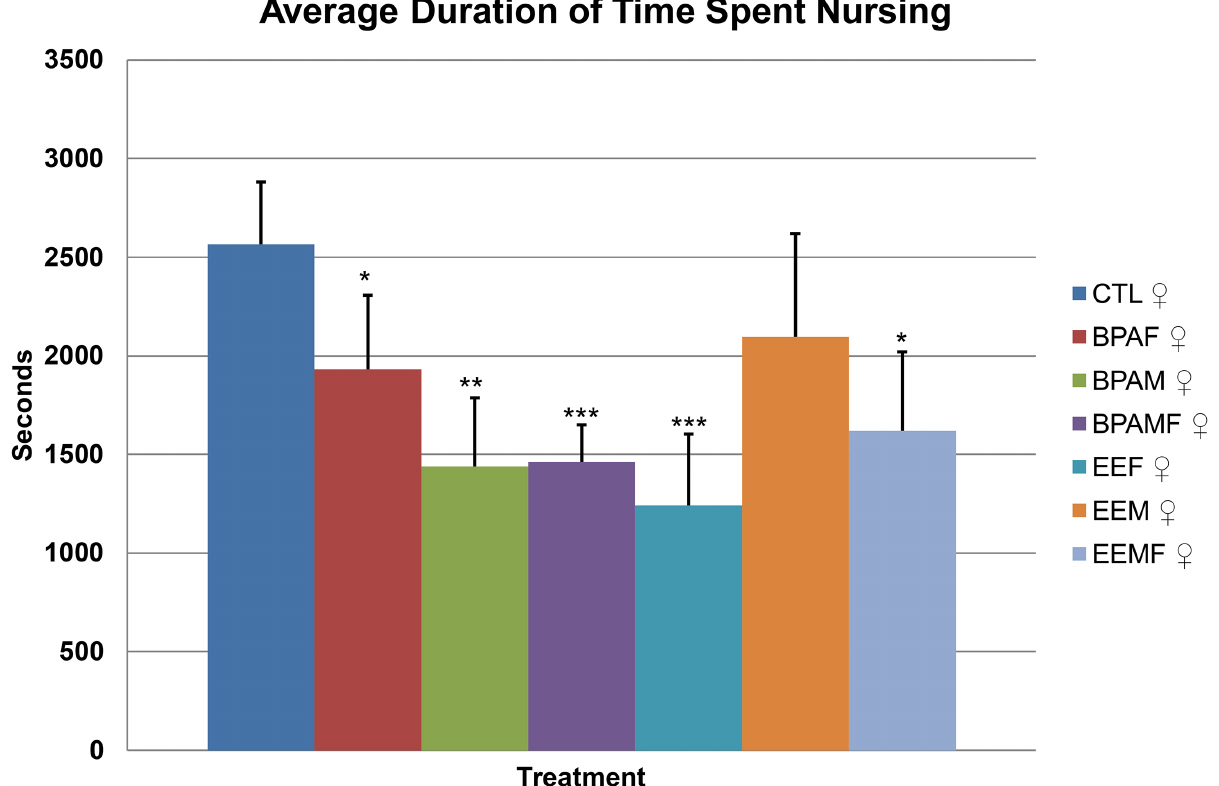
Fig 2. Average hourly duration of time from the day of birth to the end of post-natal day 5 that females spent nursing their pups. Treatment groups that are significantly different from control pairings are denoted with * P < 0.05; *** , P < 0.001.